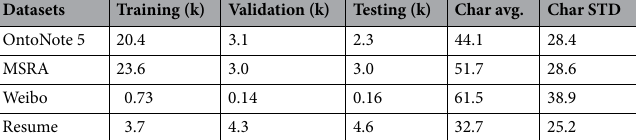
Table 1. Information of